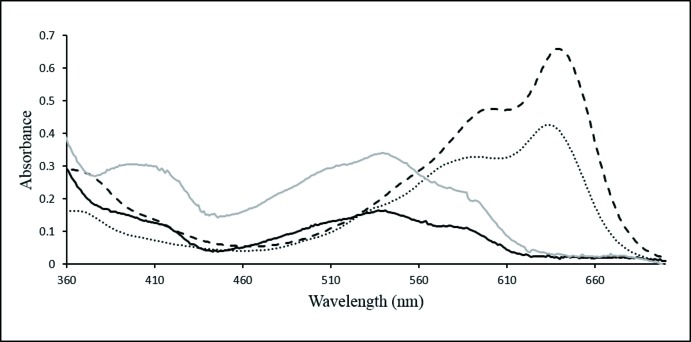
UV/vis spectra of 1·2CHCl3 in (____) CHCl3, (- - - -) ethanol, (____) CH2Cl2, and (⋯⋯) methanol. The absorbance axis is ×10 for the CHCl3 and CH2Cl2 solutions.